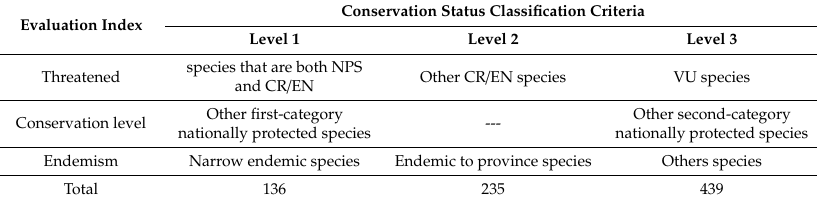
Table 1. Classification of species according to the level of their conservation